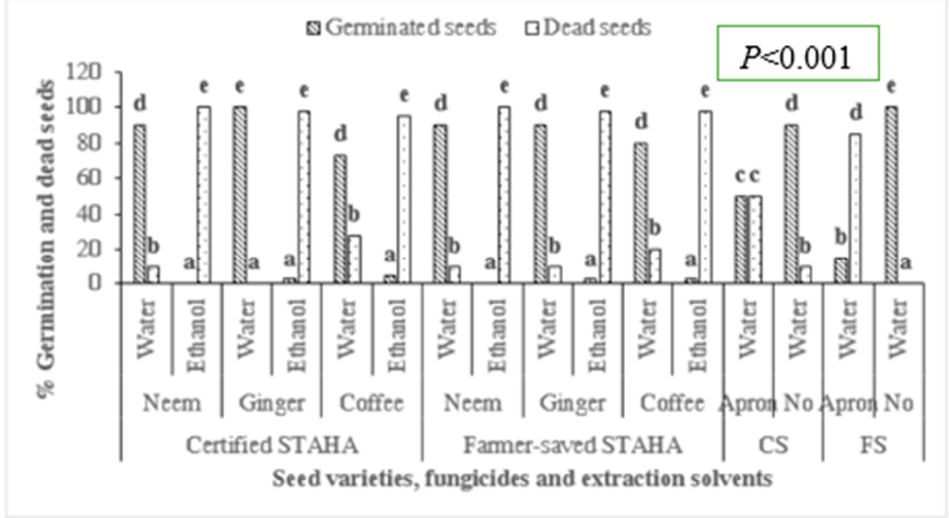
Figure 7. Effects of a three-way interaction between seed sources, fungicides, and extraction solvents on percentages of germination and dead seeds. Means with the same letters along the same bars are not significantly different ( p < 0.05).